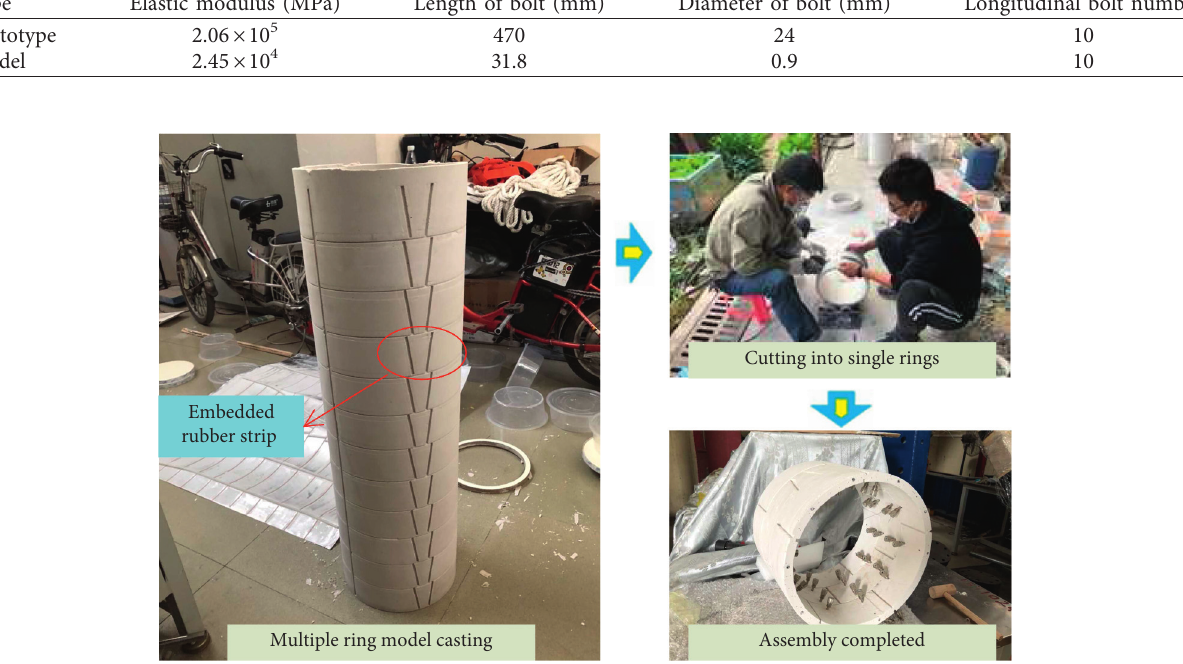
Figure 8: Brief fabrication process of segmental